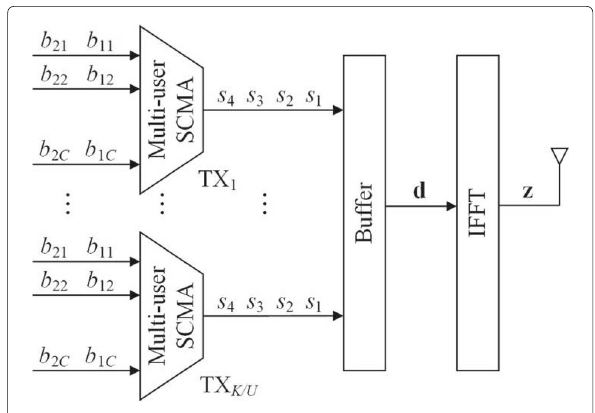
Fig. 3 Block diagram of the parallel multi-user SCMA-OFDM